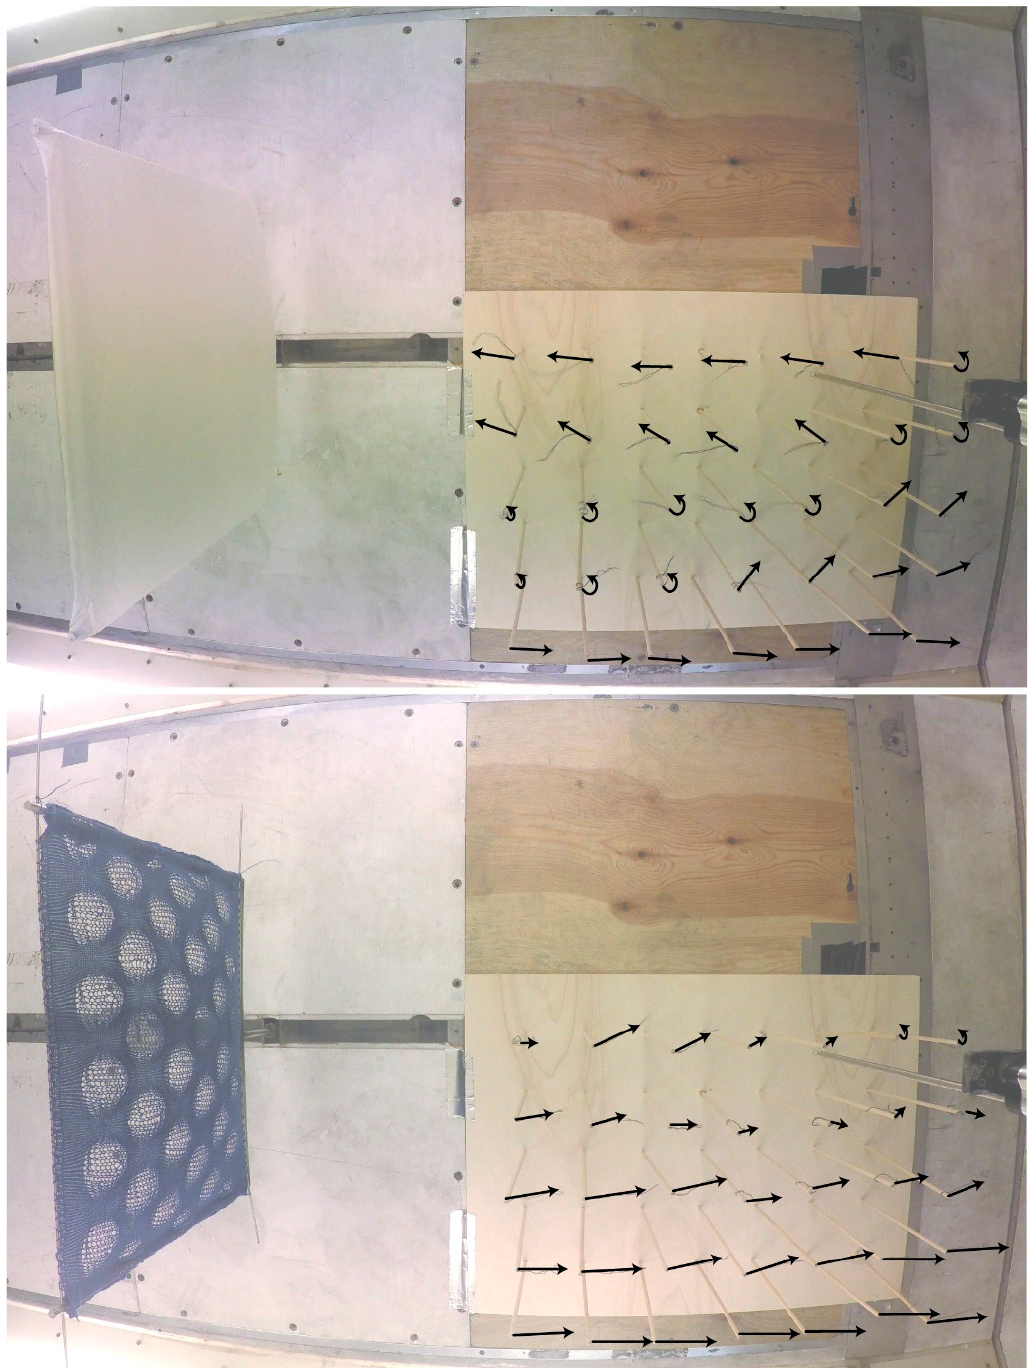
Figure 11. Illustration of wind direction downwind for drop-stitch and solid screen at 8 m/s. Arrows are an interpretation of wind direction and speed, based on both photos and video filming. Circular arrows depict tufts which were moving randomly without well-defined direction but tended to turn in the direction of the arrow. The length of arrows, representing velocities, is based on the interpretation of the amplitude with which the tufts were fluctuating.